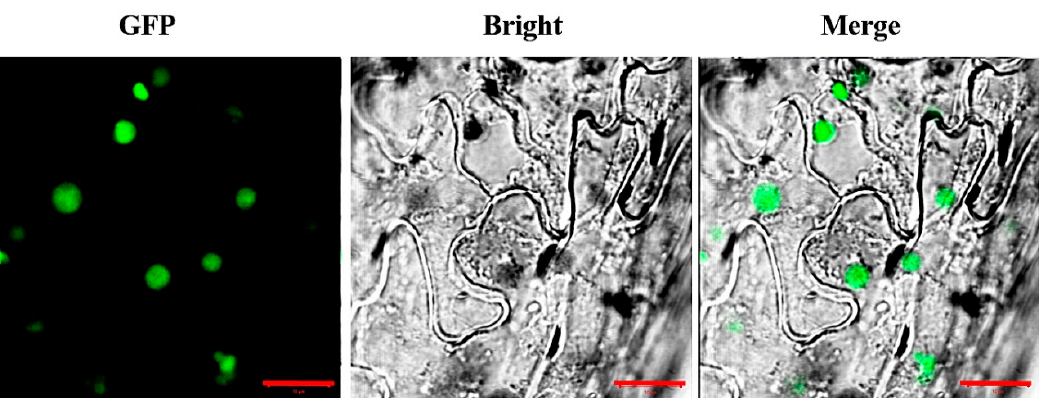
Figure 4. Subcellular localization of AaCOI1. GFP, GFP fluorescence; Bright, bright-field image; Merge, merged GFP and bright-field image. The scale bar represents 10 μ m.